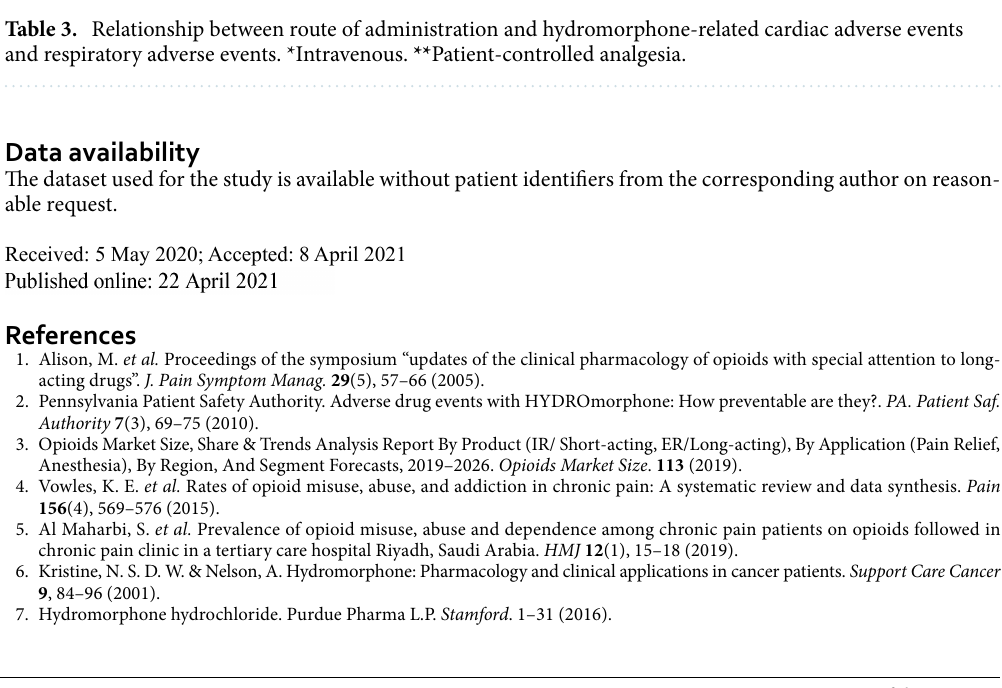
Table 3. Relationship between route of administration and hydromorphone-related cardiac adverse events and respiratory adverse events. *Intravenous. ** Patient-controlled analgesia.